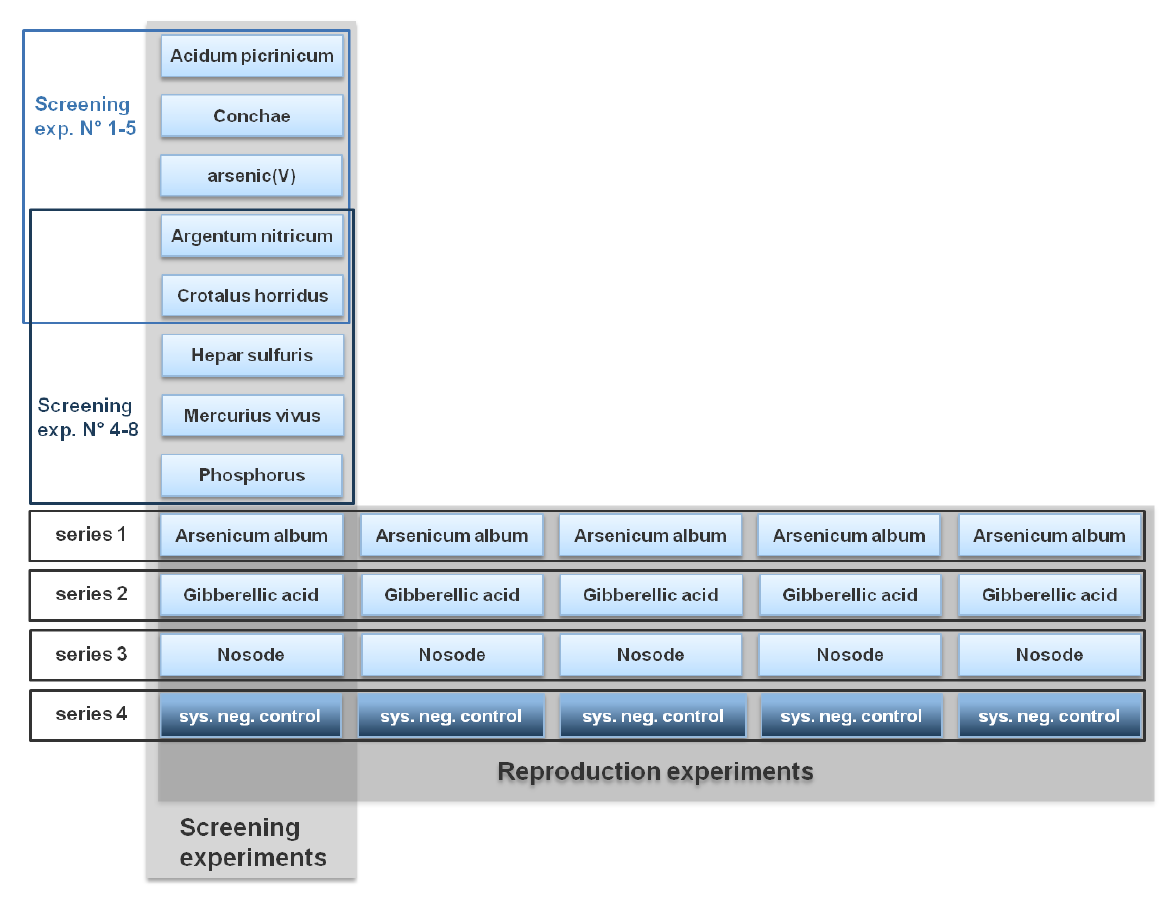
FIGURE 2. Diagram of all analyzed experiments. One box corresponds to one single experiment. The present data evaluation comprised for each of the experimental series (series 1–4) five independent experiments (sys. neg. control = systematic negative control experiment). Additional control calculations were made with two groups of eight screening experiments (N° 1–5 and N° 4–8). Data of the screening experiments were evaluated and published